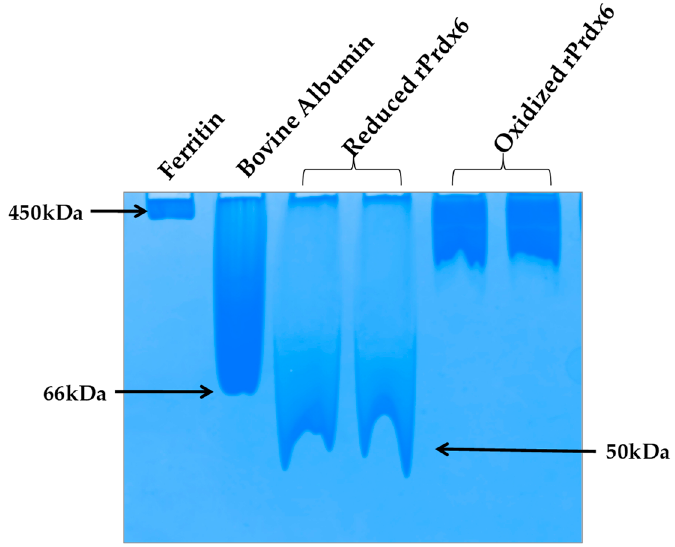
Figure 6. Native-PAGE.Reduced and hyperoxidized Pdrx6s along with bovine serum albumin and horse ferritin as a marker under non-reducing and non-denaturing conditions in the buffer 150 mM beta- alanine and 100 mM lactic acid (85–90%), pH 3.8.